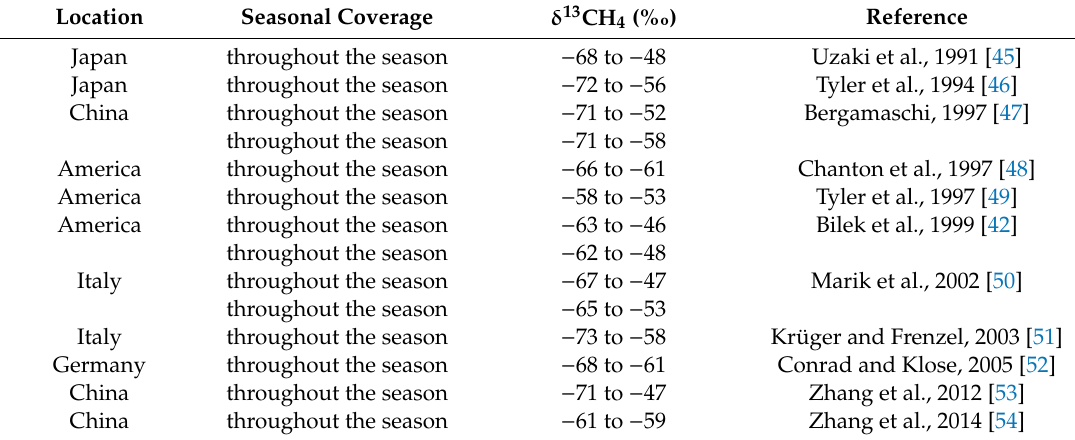
Table 1. Overview of δ 13 C values of CH 4 emissions in different countries from rice fields a.